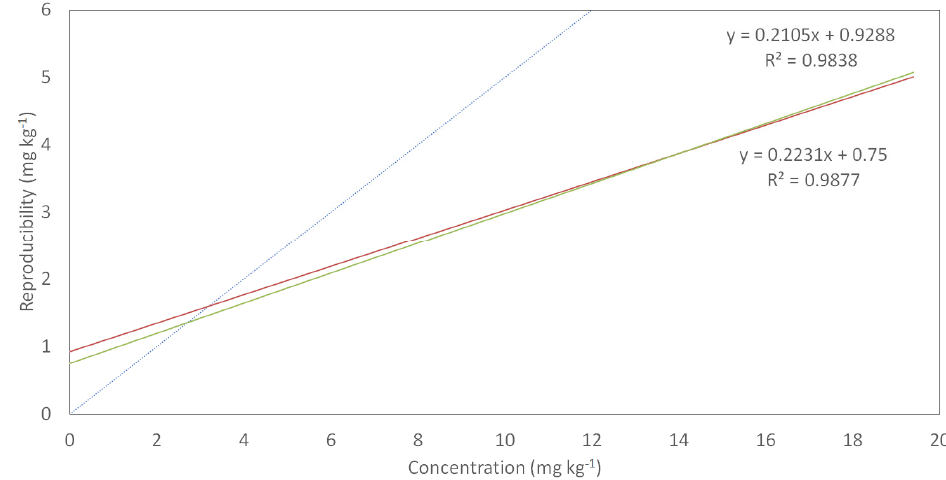
Figure A3. Reproducibility vs. mean Cr(VI) concentration plots from the data presented in annex B (Figure B.1) of BS EN ISO 17075:1-2017 [11]. Author derived linear regression of the figure points (red) are compared to the linear regression shown in Figure B.1 (green). Table A1. Limit of quantification (LOQ) values derived from the intersection of the 50% error trendline with the trendlines in Figures A2 and A3. Data Source Figure B.1 Linear regression of data points in Figure B.1